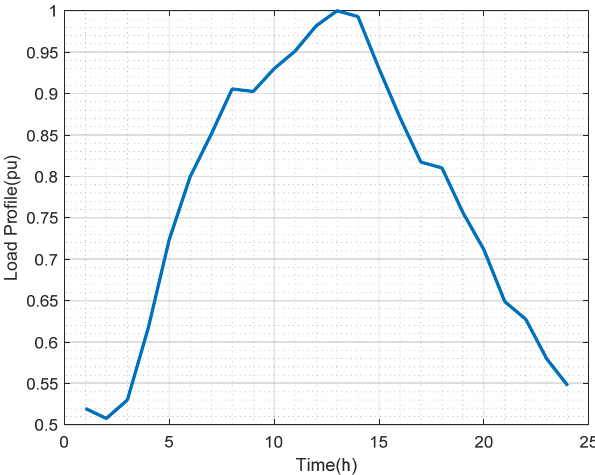
Figure 3. Typical load profile data.